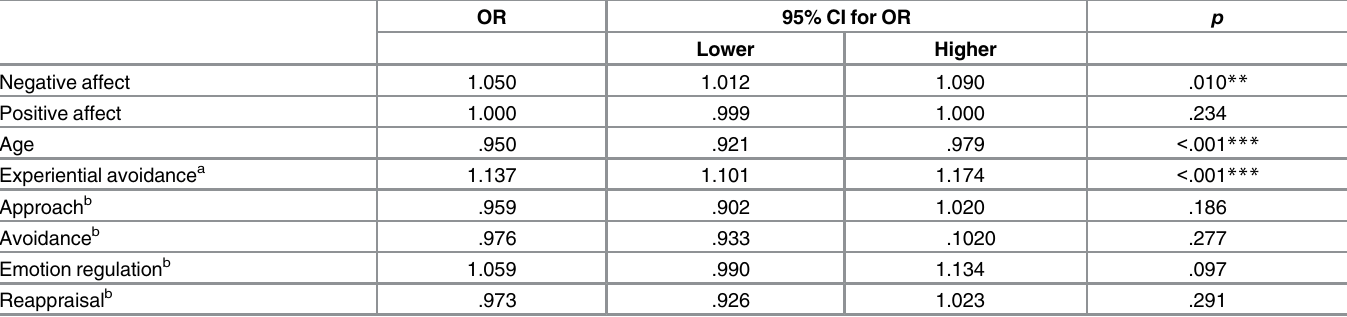
Table 4. Multivariate binary logistic regression exploring whether functional coping dynamics and experiential avoidance predict lifetime history of self-harm, when adjusting for age and affect ( n = 1173).